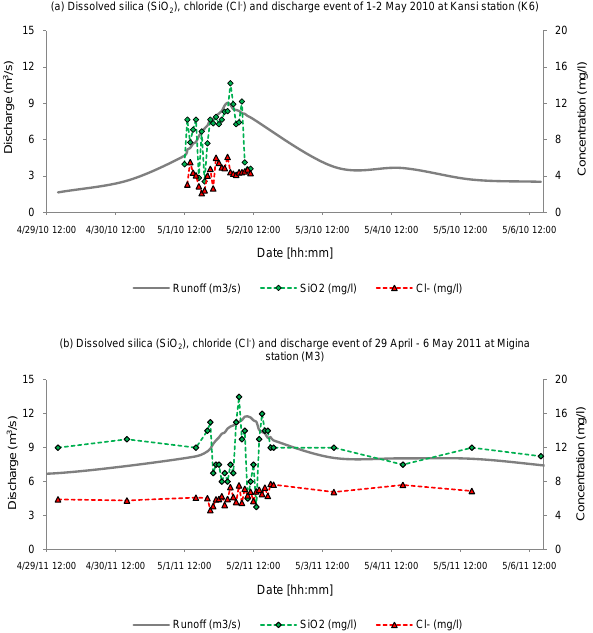
Hydrograph separation based on dissolved silica (SiO 2 ) at Kansi station